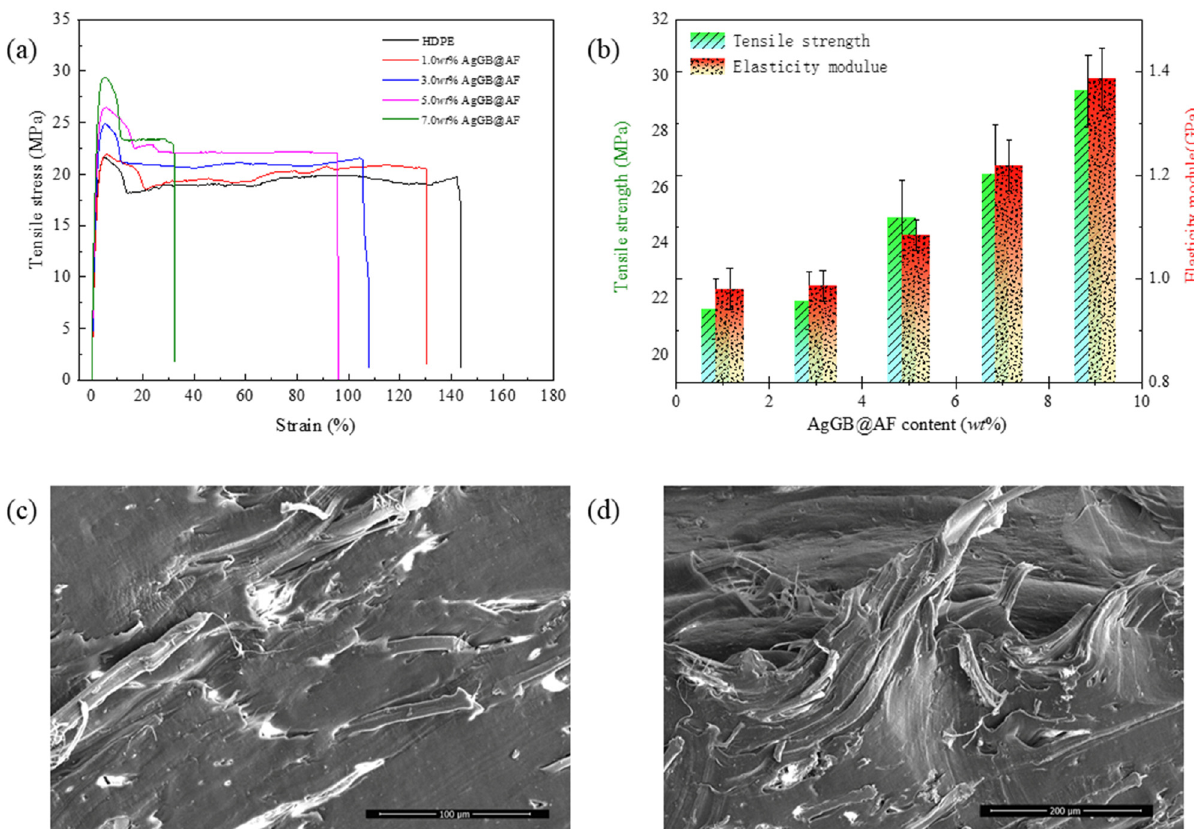
Figure 6: ( a ) Tensile curves and ( b ) tensile strength, ( c ) surface, and ( d ) fracture surface of HDPE